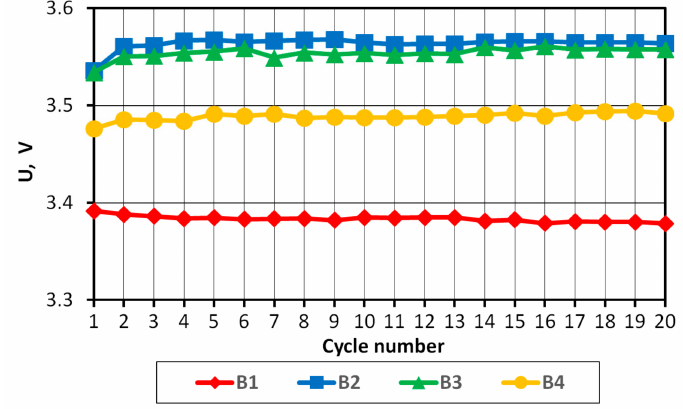
Figure 5. Battery voltage at the end of successive charging cycles.